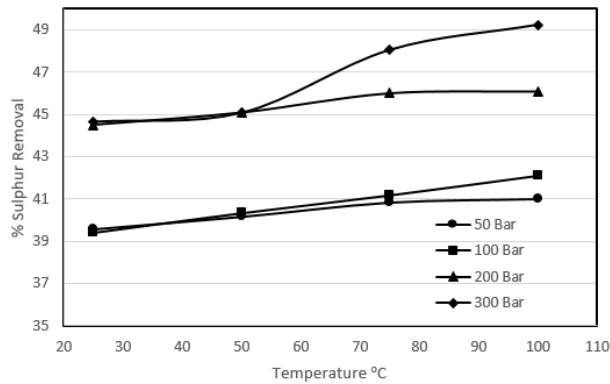
Figure 4. Effect of temperature on the pyritic sulphur removal.